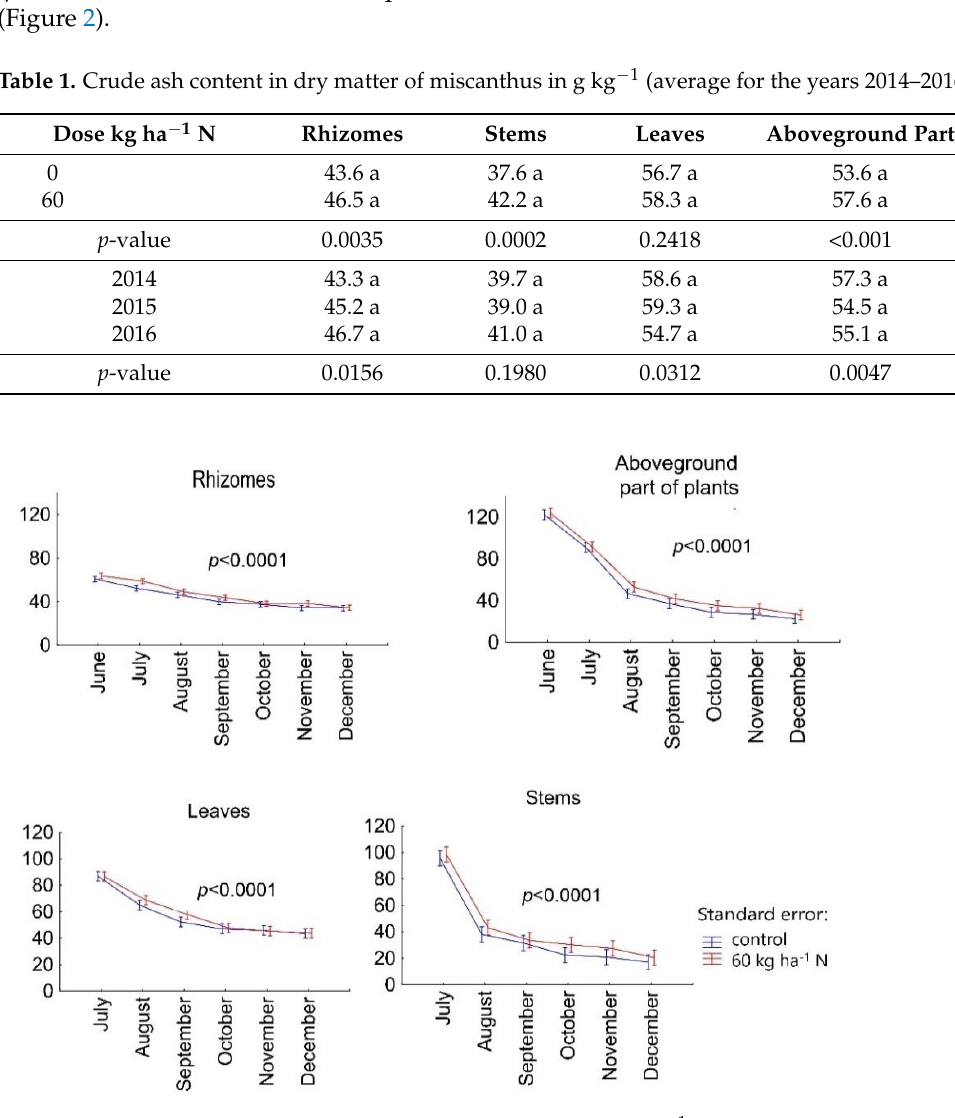
Figure 2. Crude ash content in examined part of miscanthus (g kg − 1 ) (three-year average content from measurements during the growing season every 30 days).